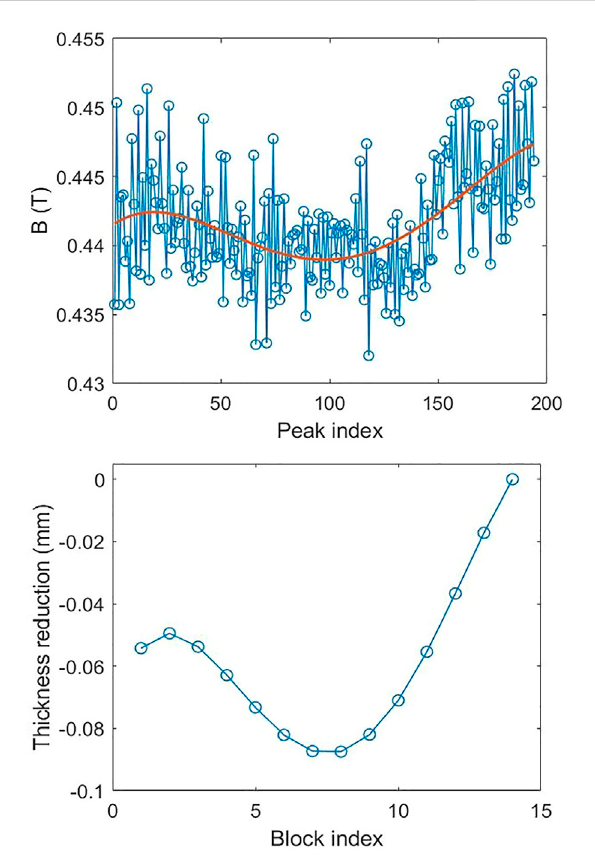
FIGURE 11 Absolute peak fi eld distribution including the fi tting curve (top) and the reduced thickness of the blocks (bottom).